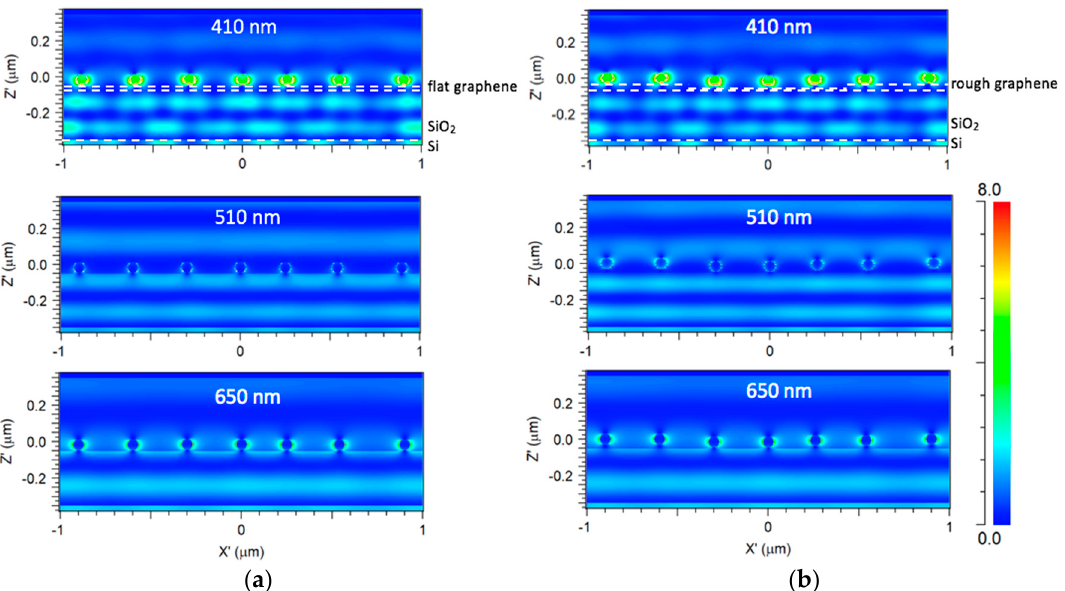
Figure 4. ( a ) Simulated electric field intensity distributions of 60 nm Ag nanoparticles/flat and few-layer graphene/SiO 2 /Si at wavelengths of 410 nm, 510 nm and 650 nm, respectively; ( b ) simulated electric field intensity distributions of 60 nm Ag nanoparticles/rough and multilayer graphene/SiO 2 /Si at wavelengths of 410 nm, 510 nm and 650 nm, respectively.